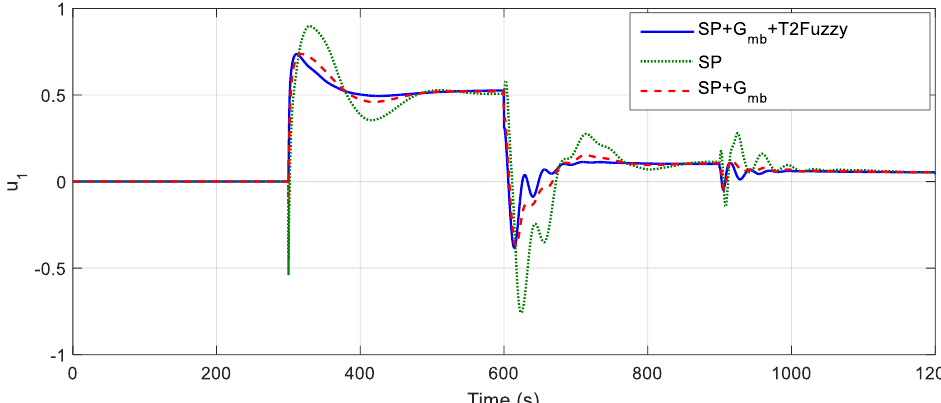
Figure 22. The control signal 𝑢 1 for all three methods for example 2.